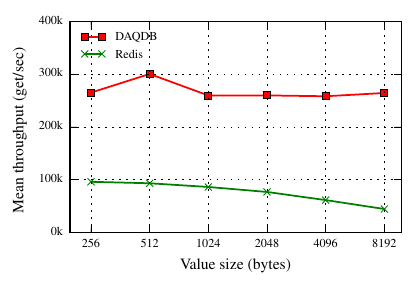
Figure 3. Base deployment model. Figure 4. Deployment model with detached storage. Figure 5. Operations per second of a single read- out thread using DAQDB and Redis for di ff erent value sizes.